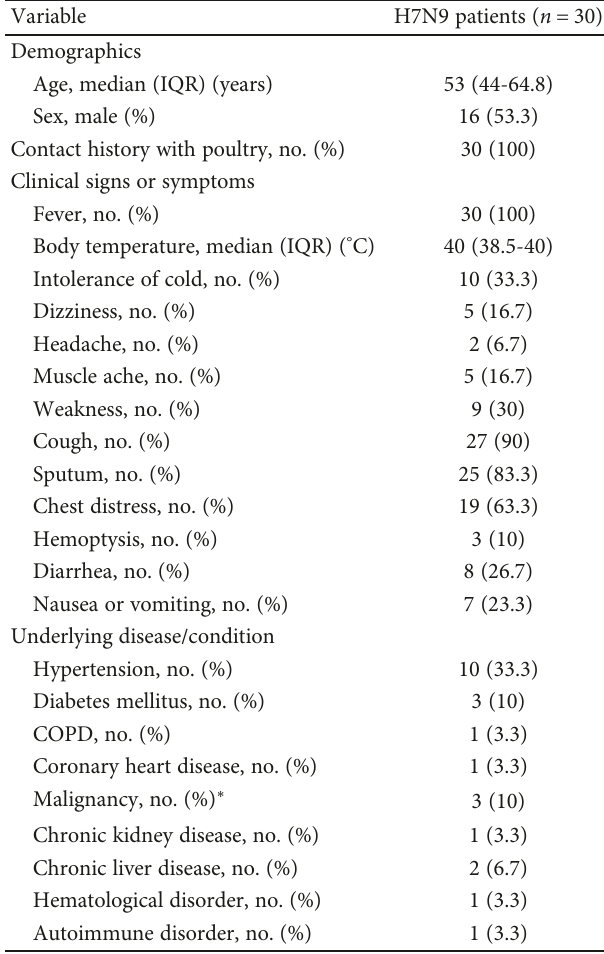
Table 1: Clinical features of patients with avian in fl uenza A (H7N9) virus